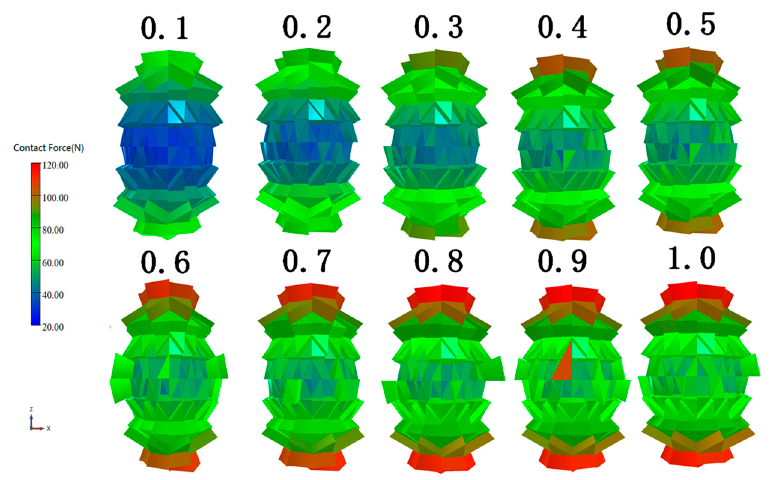
Figure 10. Normal contact force distribution of different cementation strength ratios .